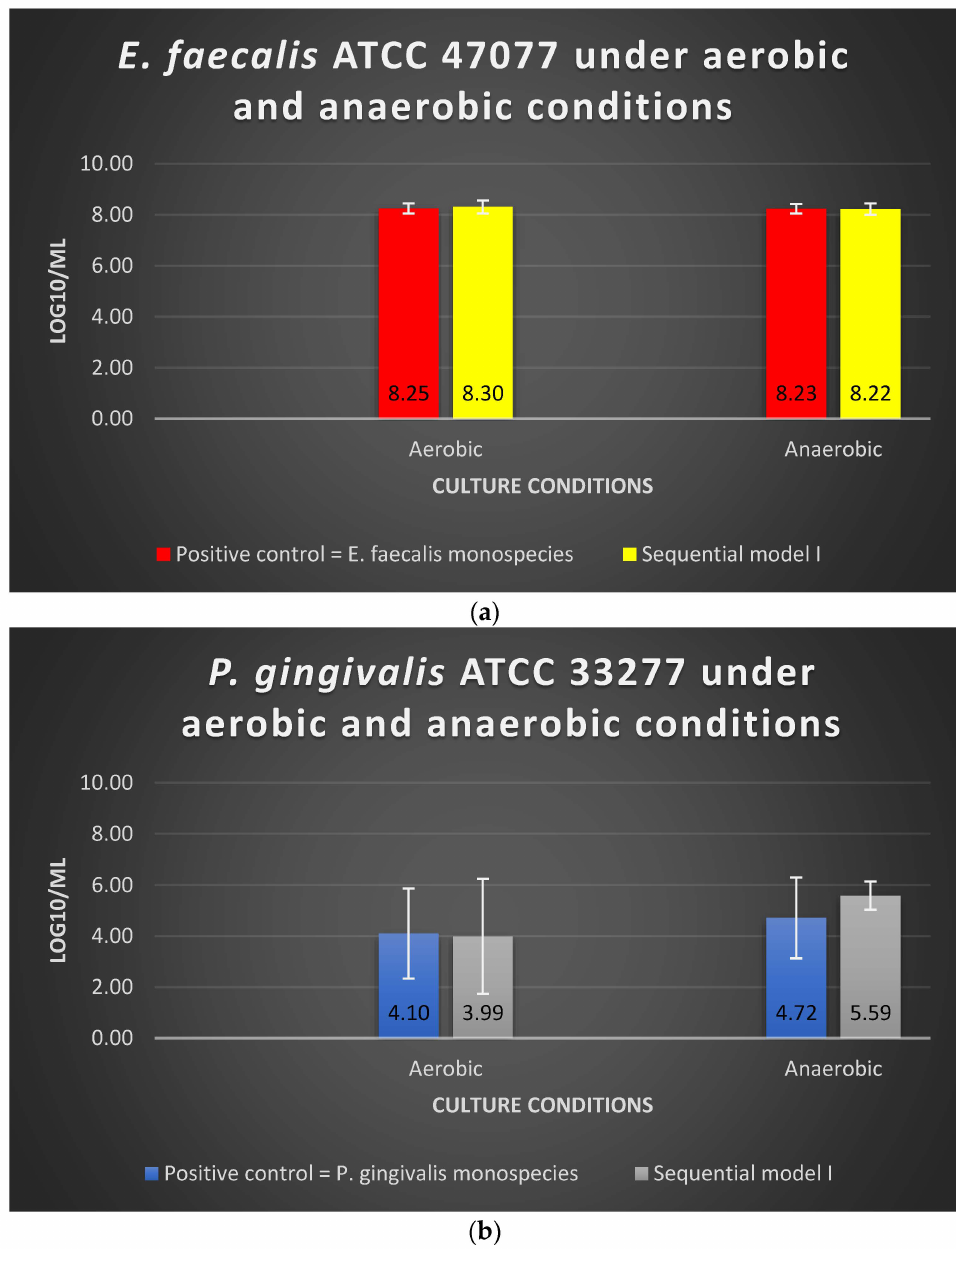
Figure 1. The viability of ( a ) E. faecalis and ( b ) P. gingivalis , cultured under aerobic and anaerobic conditions based on the Sequential model I and mono-culture models. Data represent the mean and standard